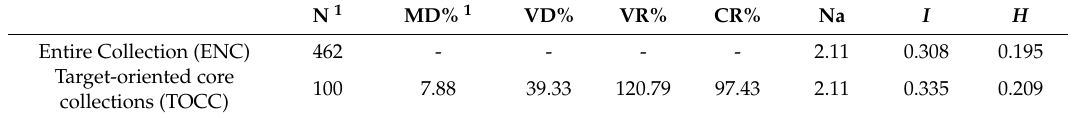
Table 7. Evaluation indices for the developed core collection.